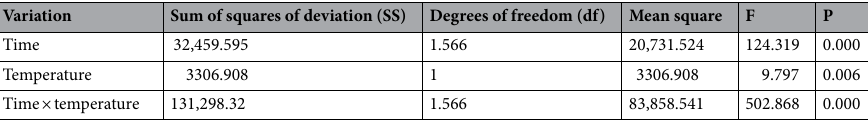
Table 4. Analysis of variance of repeated measurement of Glu.